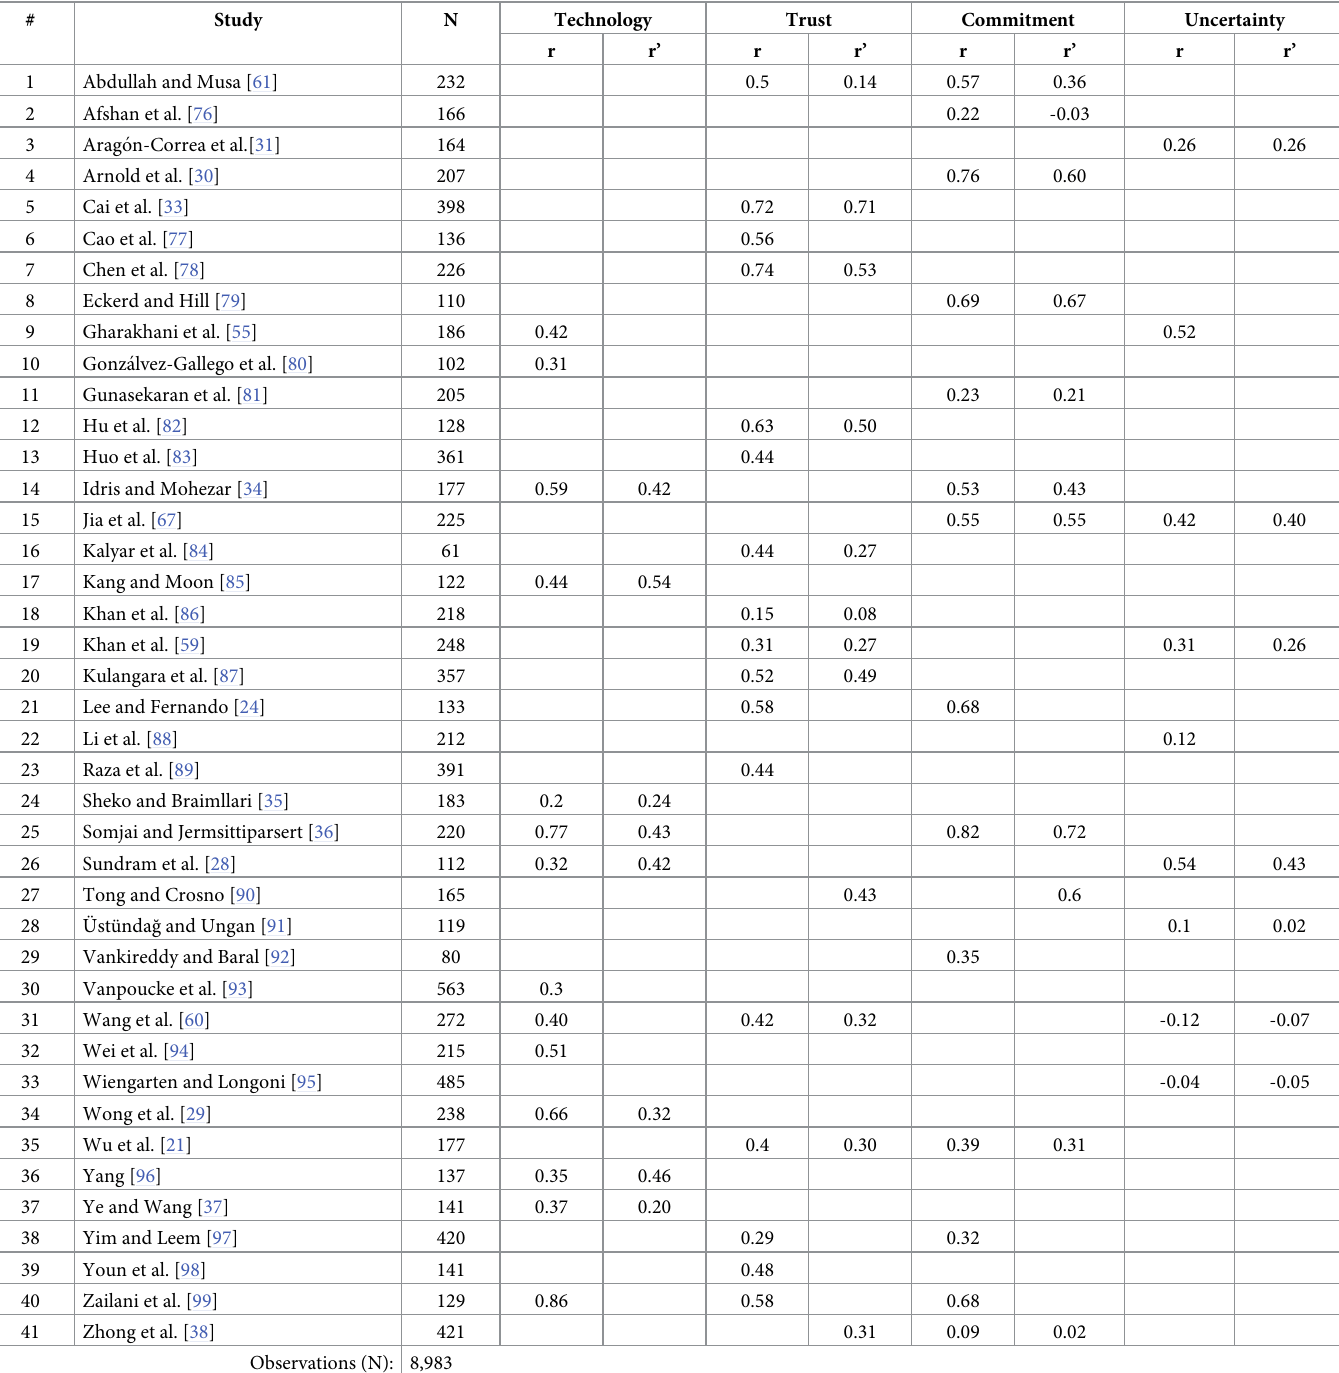
Table 2. Correlation and partial correlation coefficient between factors and information sharing in relevant